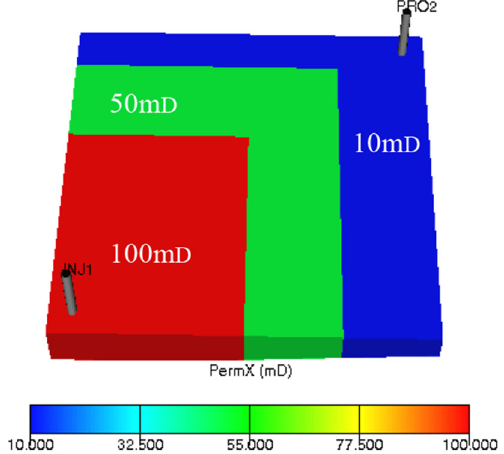
Fig. 4 Porosity model for injecting into thick layers and producing from thin ones